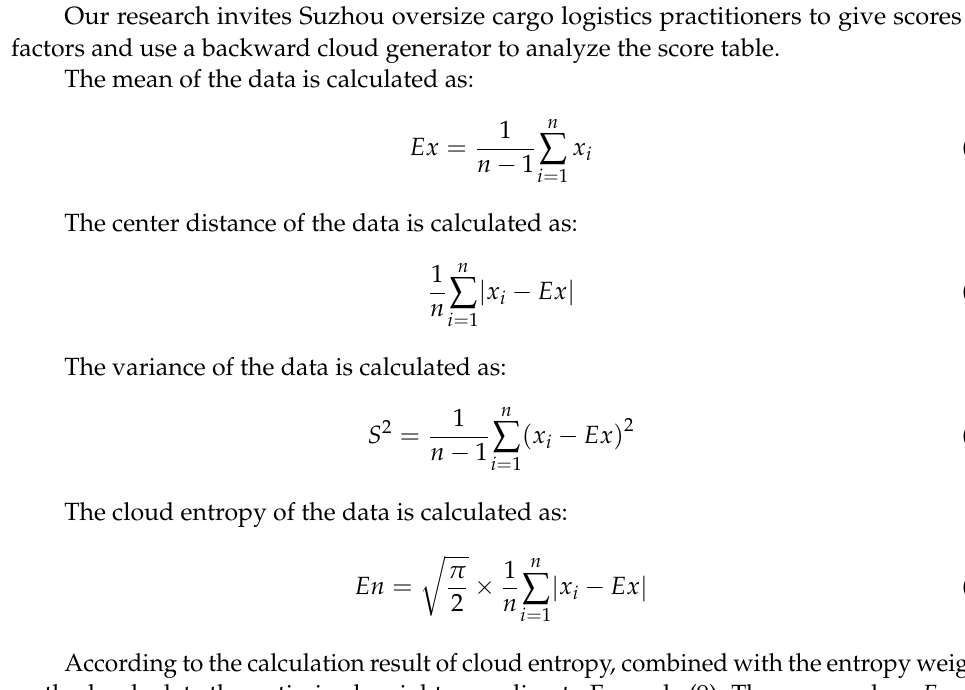
Figure 2. Backward cloud generator.